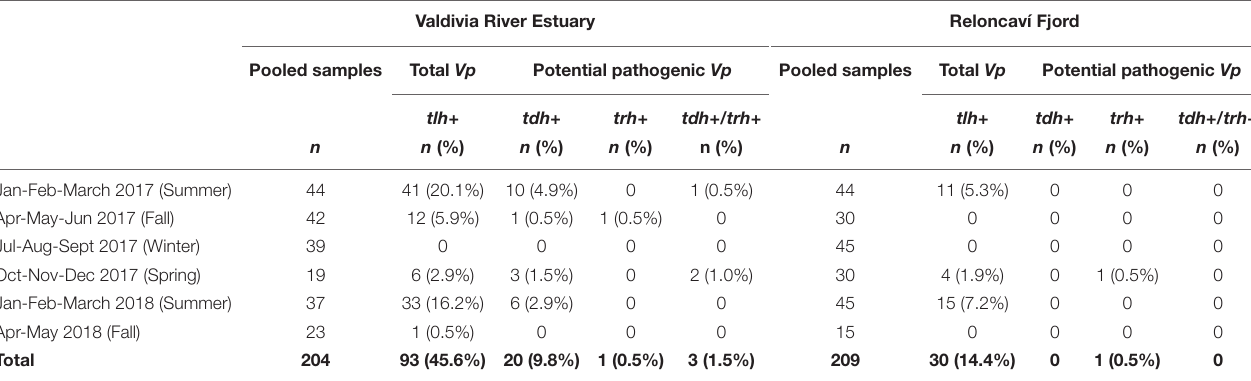
TABLE 4 | Prevalence of total V. parahaemolyticus ( tlh +) and potential pathogenic V. parahaemolyticus ( tdh + and/or trh +) in pooled samples of M. chilensis from Valdivia River Estuary and Reloncaví Fjord stratified by weather season (summer, fall, winter and spring).